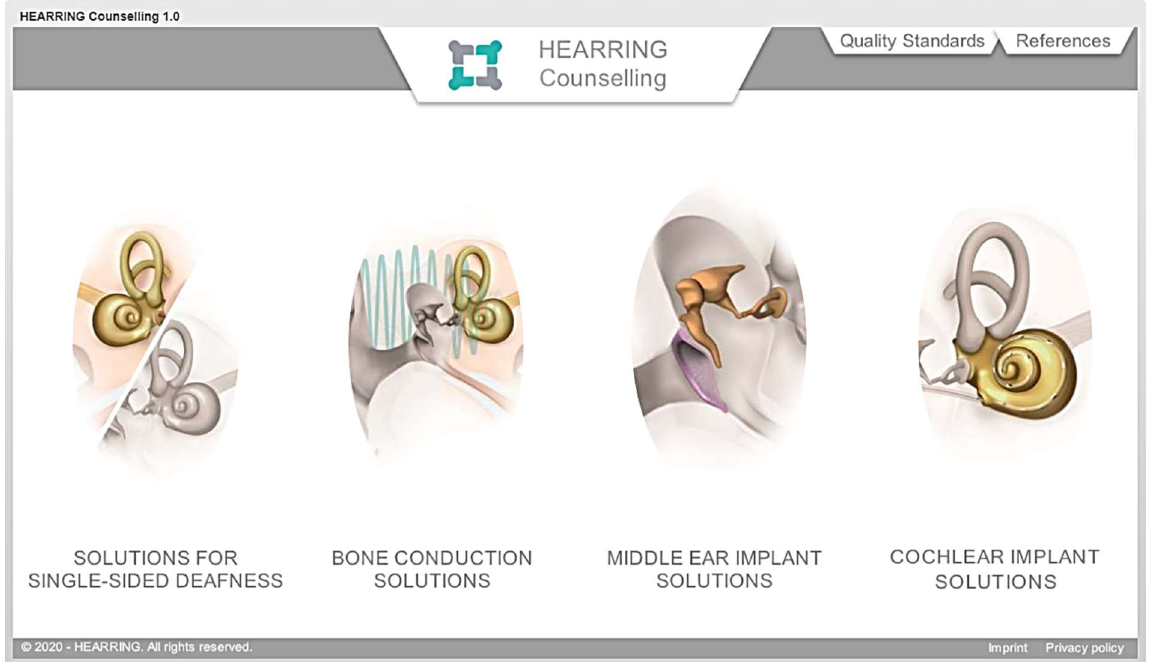
Figure 2. The home screen of the HEARRING counselling platform 1.0.